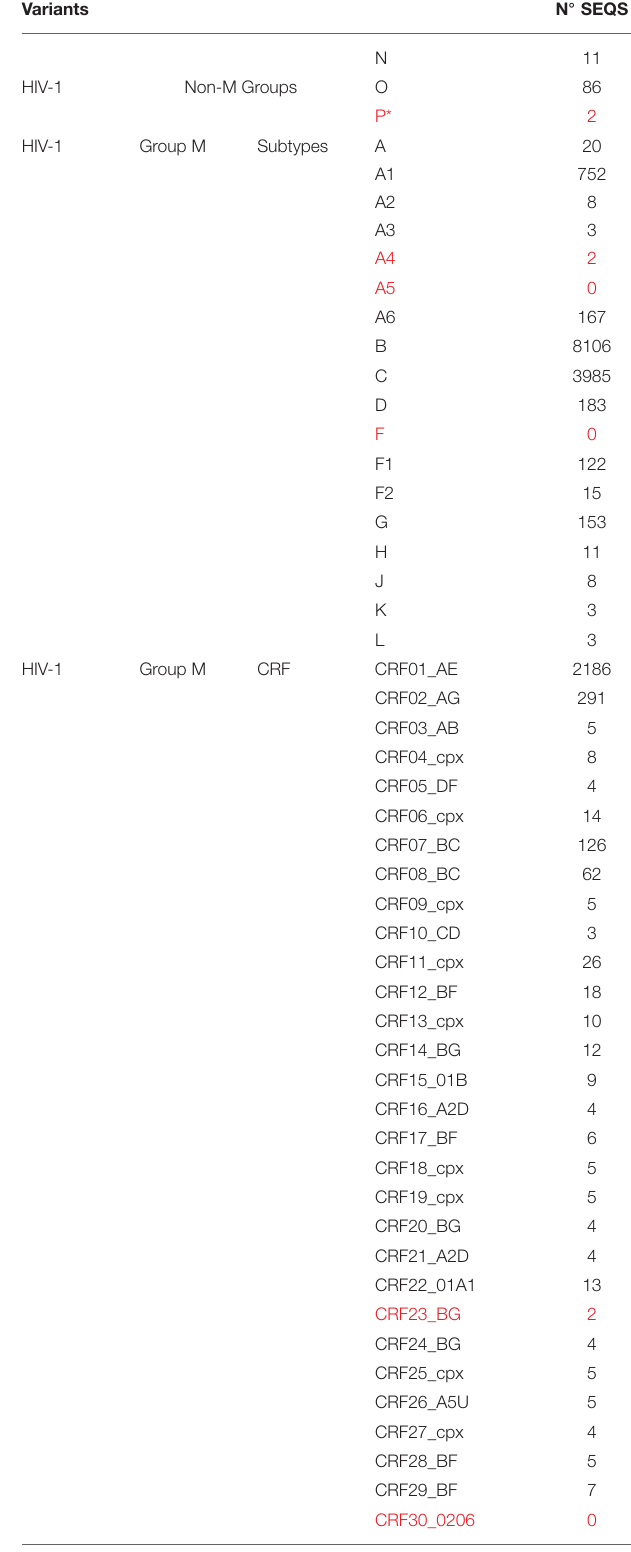
TABLE 1 | Gp41/gp36 LANL sequences were analyzed in this